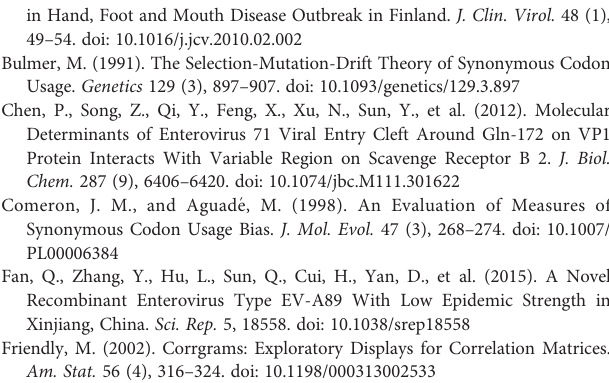
Supplementary Figure 1 | Phylogenetic analysis of the EV-A stains. Supplementary Figure 2 | Genotype-speci fi c of correspondence analysis plots were constructed for individual EV-A coding sequences. Supplementary Figure 3 | ENC – GC3 plots. Supplementary Figure 4 | Neutrality plot analysis. Supplementary Figure 5 | RCDI and SiD analysis of the EV-A coding sequences against model organisms. Supplementary Table 1 | Demographics of Enterovirus A genomes analyzed in present study. Supplementary Table 2 | Nucleotide composition analysis of EV-A coding sequences. Supplementary Table 3 | One way Anova analysis between three clades. Supplementary Table 4 | Summary data of CAI, RCDI and SiD